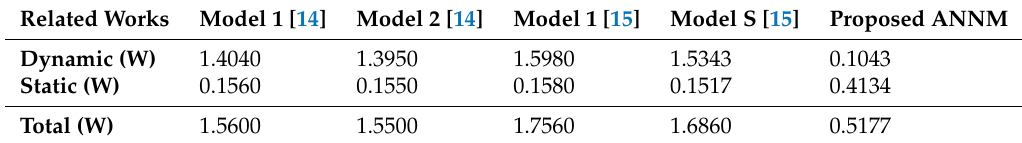
Table 13. Comparison of power consumption with related